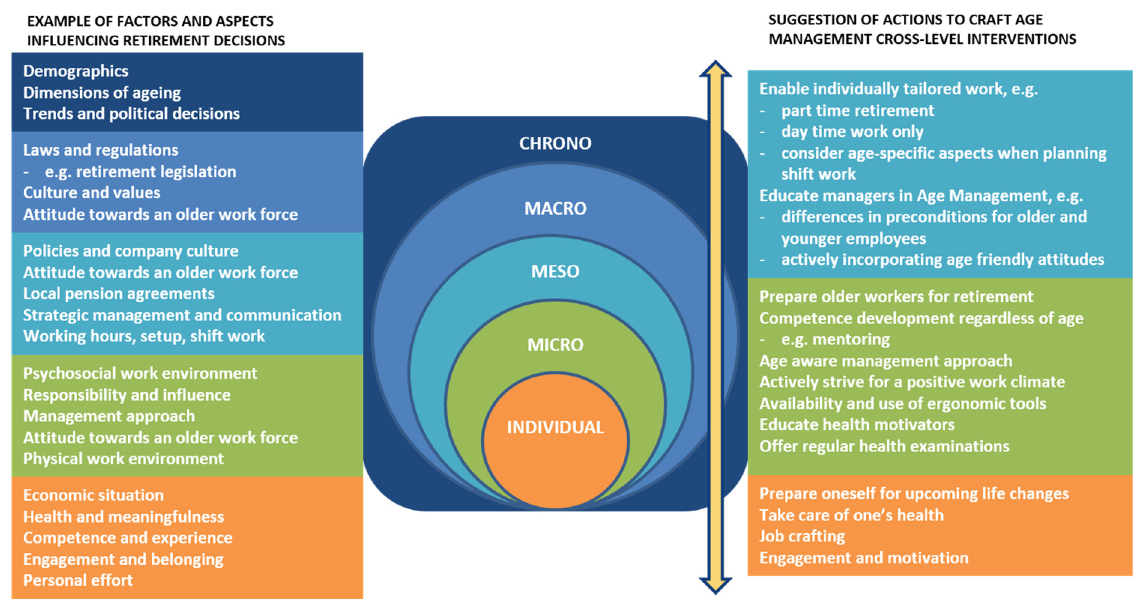
Figure 2. Examples of important aspects and age management actions suggestions based on the results. The arrow indicates the interplay between the levels (modified from [35]).